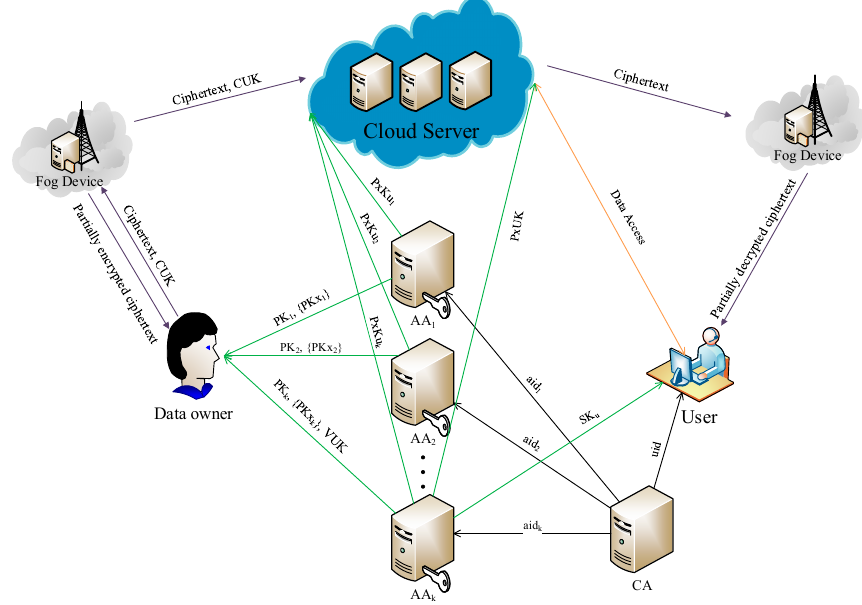
Figure 2. System model of multi-authority access control in fog-cloud system.